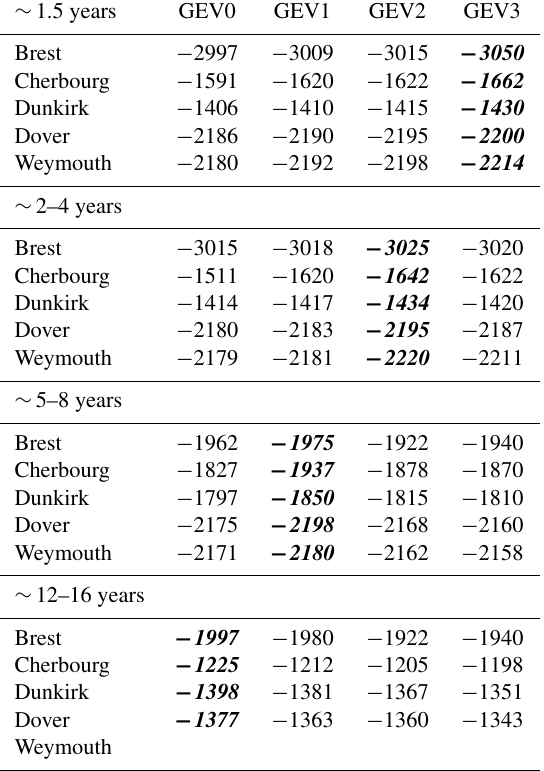
Table 4. AIC test results for the distribution models of the extreme surges using the stationary (GEV0) and the nonstationary (GEV1- 3) models combined with climate oscillation indices. The stationary (GEV0) and nonstationary GEV (GEV1, GEV2 and GEV3) mod- els are illustrated for each timescale and each site. The lowest AIC values for each case are marked in italics. The lowest frequency of ∼ 12–16 years is not observed in Weymouth.